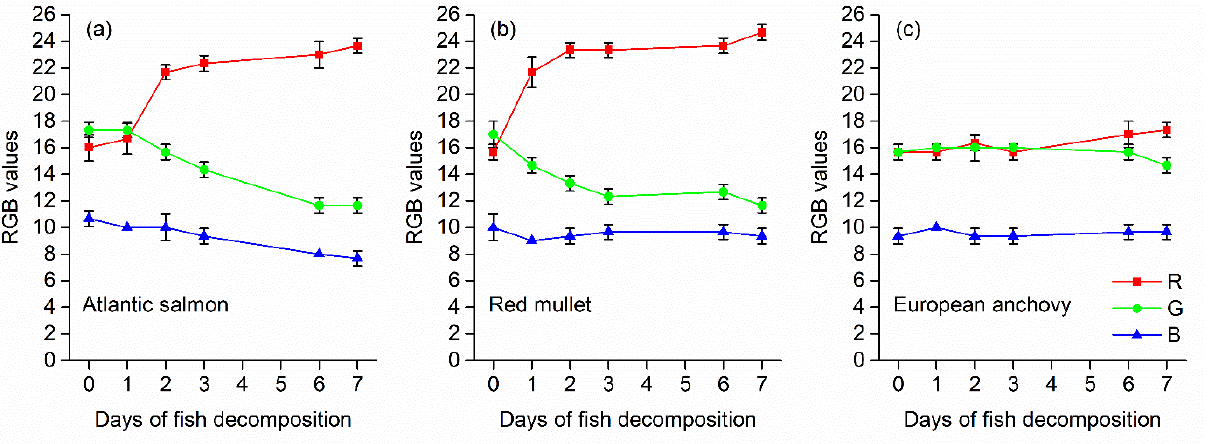
Figure 8. Color evolution (RGB coordinates) of PCN-224/PDMS films over six days of exposure to fish left to decompose. Left to right: ( a ) Atlantic salmon, ( b ) Red mullet, ( c ) European anchovy.